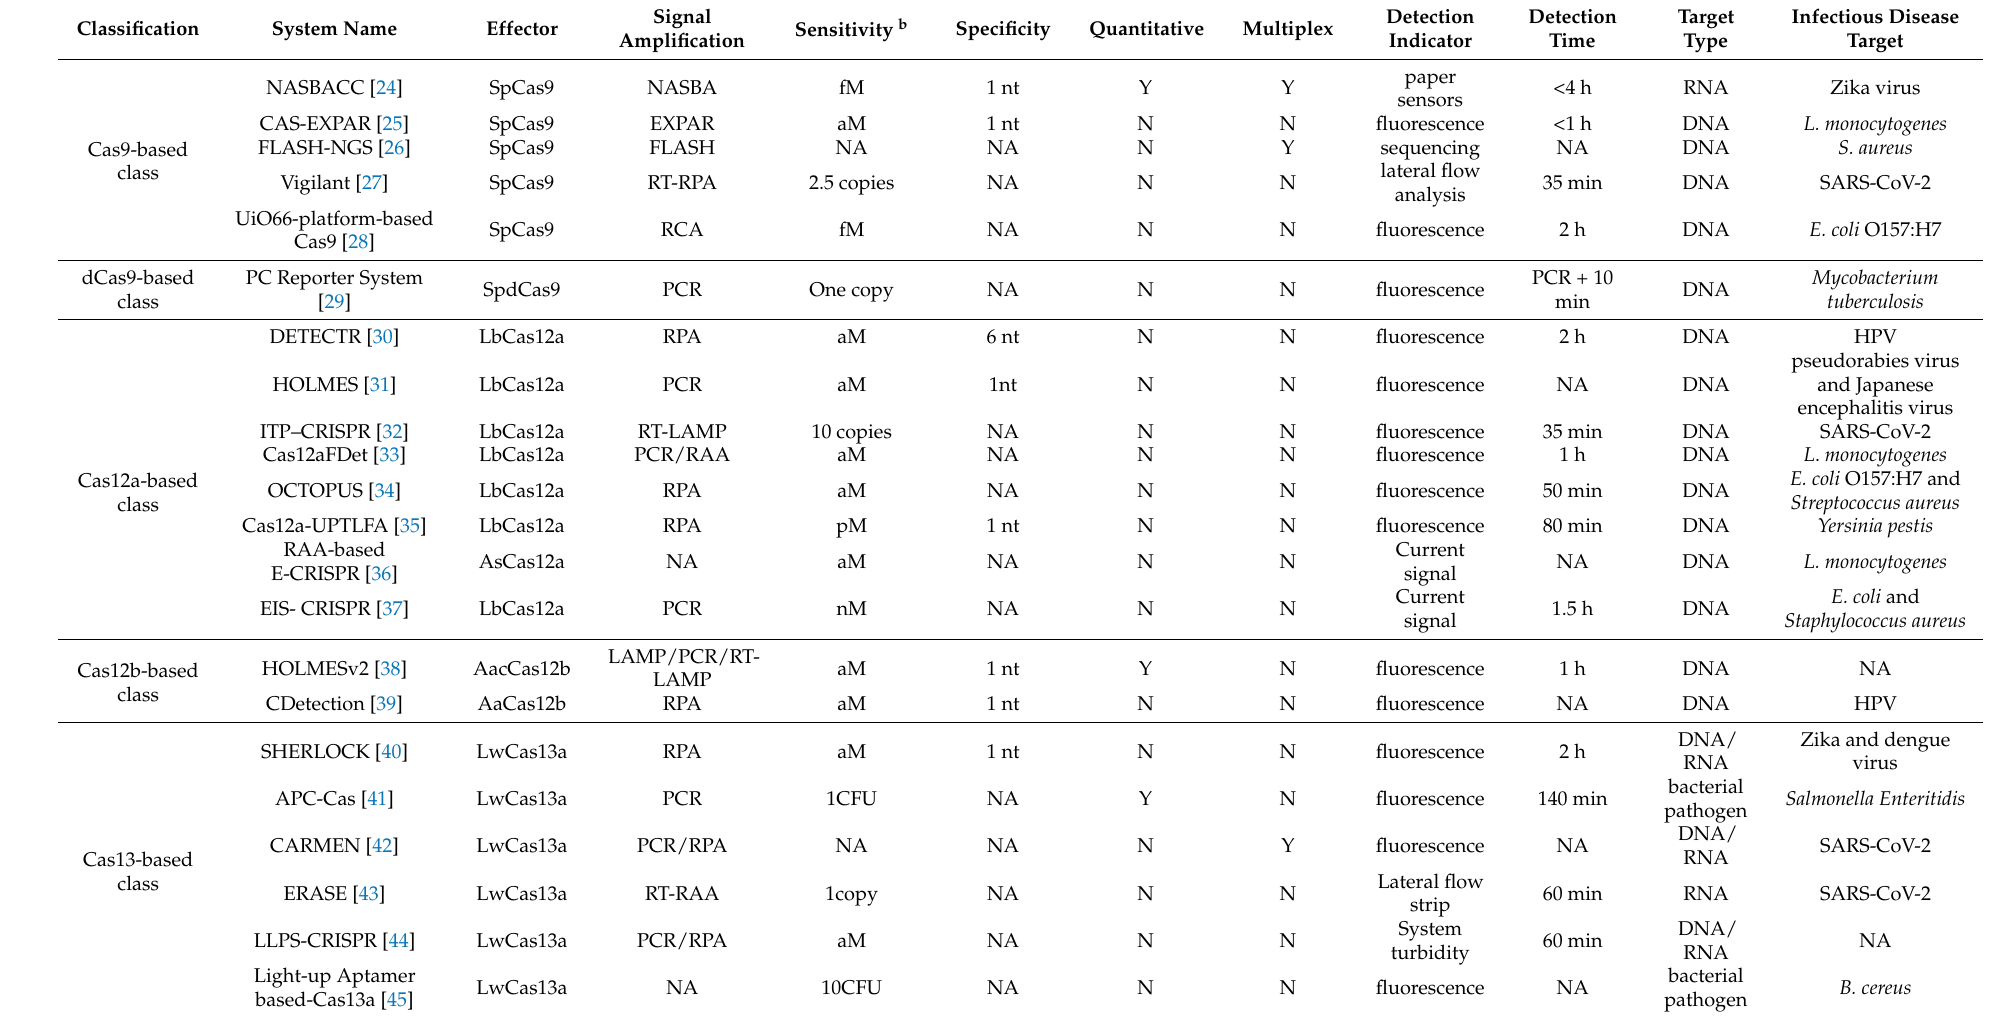
Table 1. Major characteristics of various CRISPR/Cas-based biosensing systems a